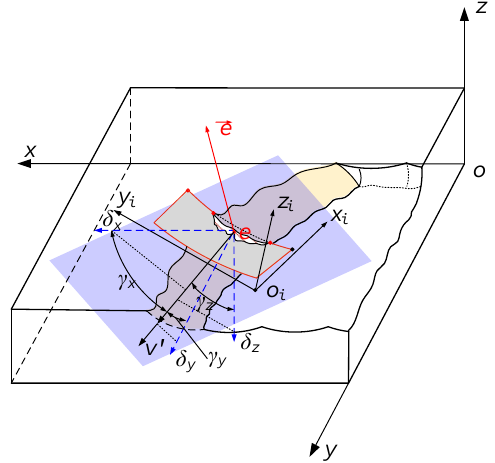
6 of 16 Figure 3. Instantaneous wear boundary of cutter tooth 1. From Equations (4) – (9), the instantaneous wear volume growth rate, V i (t), and the accumulated wear volume, Σ V i , at the friction contact points within the friction wear boundaries are: